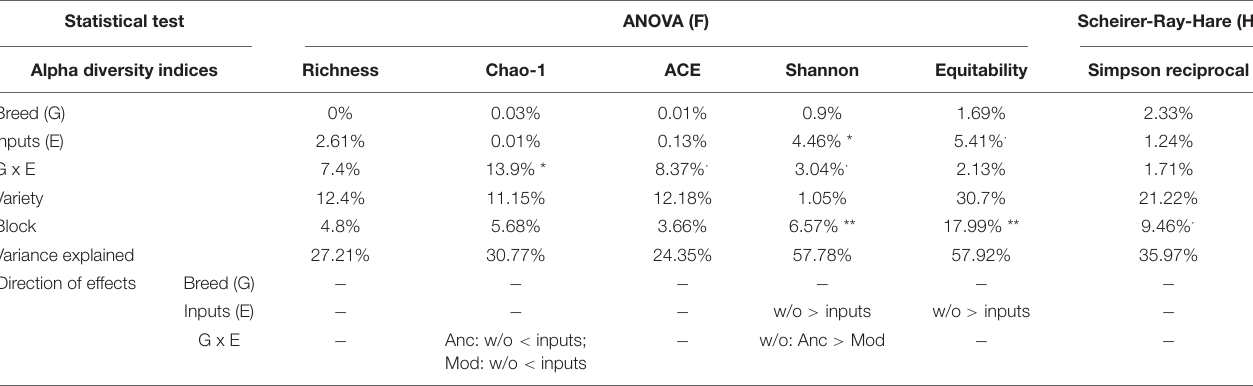
FIGURE 3 | Alpha diversity of the rhizosphere fungal community (ITS2 gene amplicon sequencing) presented as reaction norms of ancient and modern wheat genotypes to environment modification by inputs. Panels are respectively showing: the (A) richness, (B) Chao-1 estimator, (C) ACE estimator, (D) Simpson reciprocal index, (E) Shannon index, and (F) Pielou’s equitability. Data are shown as the interaction between breeding type and the presence/absence of inputs (w/o: without inputs; w: with inputs; N = 11–14, error bars are standard error of the mean). Significance was inferred with an ANOVA under Tukey’s HSD post hoc test for normally distributed data (honest significant differences, p < 0.05). Data that are not normally distributed were analyzed by Scheirer-Ray-Hare test followed by post hoc FDR test correction to account for multiple testing (FDR, p < 0.05). TABLE 4 | Analysis of variance for fungal alpha diversity